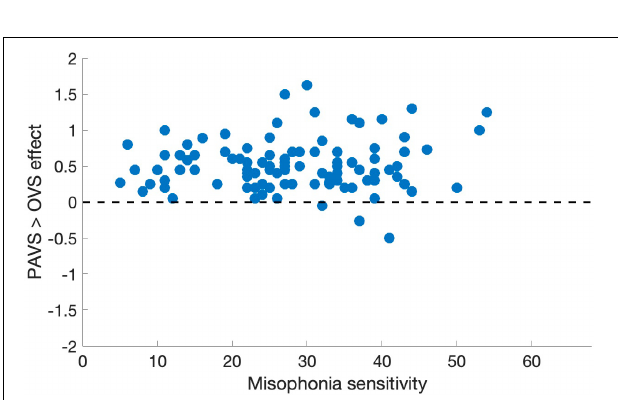
FIGURE 6 | The effect of order of presentation on pleasantness ratings. Blue bars show mean pleasantness ratings for PAVS videos and red bars show mean pleasantness ratings for OVS-paired sounds. The first pair of bars shows results for sounds that were rated in the PAVS context first and OVS context second; the second pair of bars shows results for sounds that were rated in the OVS context first and PAVS context second. Error bars denote one standard error of the mean across 102 observers. The asterisks indicate a significant difference ( p < 0.0001).